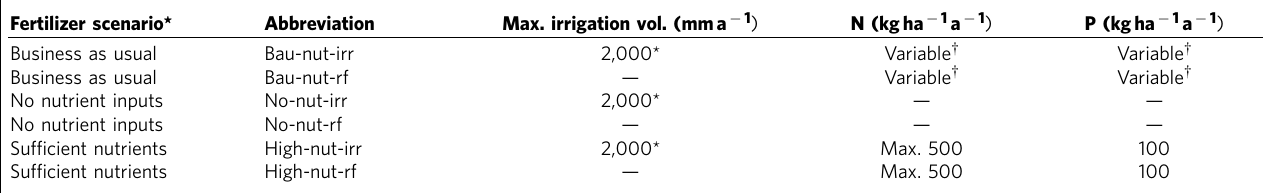
Table 3 | Nutrient and water management scenarios used in the study. Fertilizer